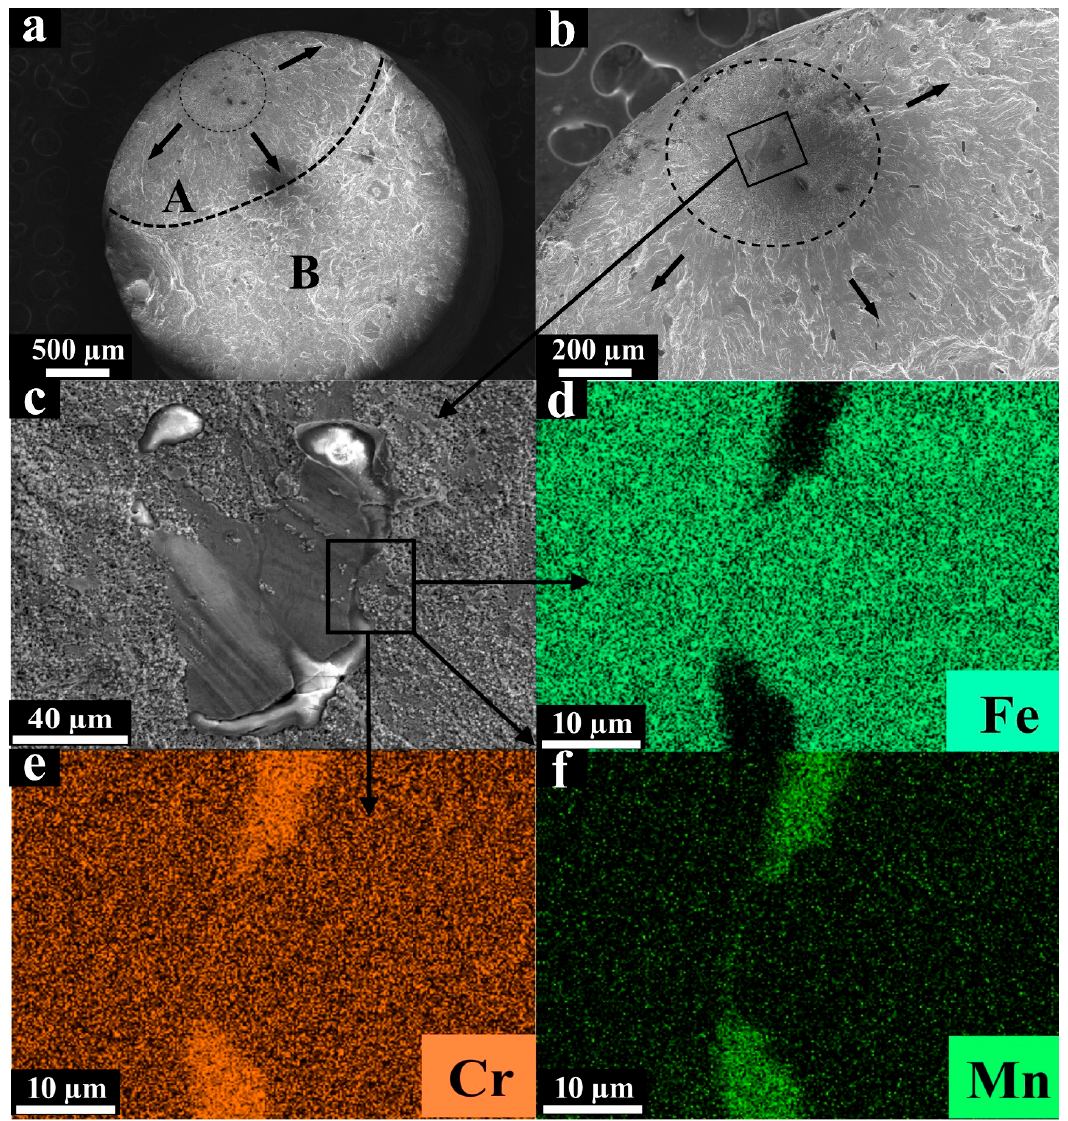
Figure 7. SEM micrographs of the fracture surfaces after loading in the VHCF regime ( σ max = 260 MPa, N = 1.5 × 10 8 cycles) of the L-PBF specimen with the assumed fusion defect, a —zones of failure; b — crack initiation site; c —internal defect; d —iron distribution; e —chromium distribution; f — manganese distribution.